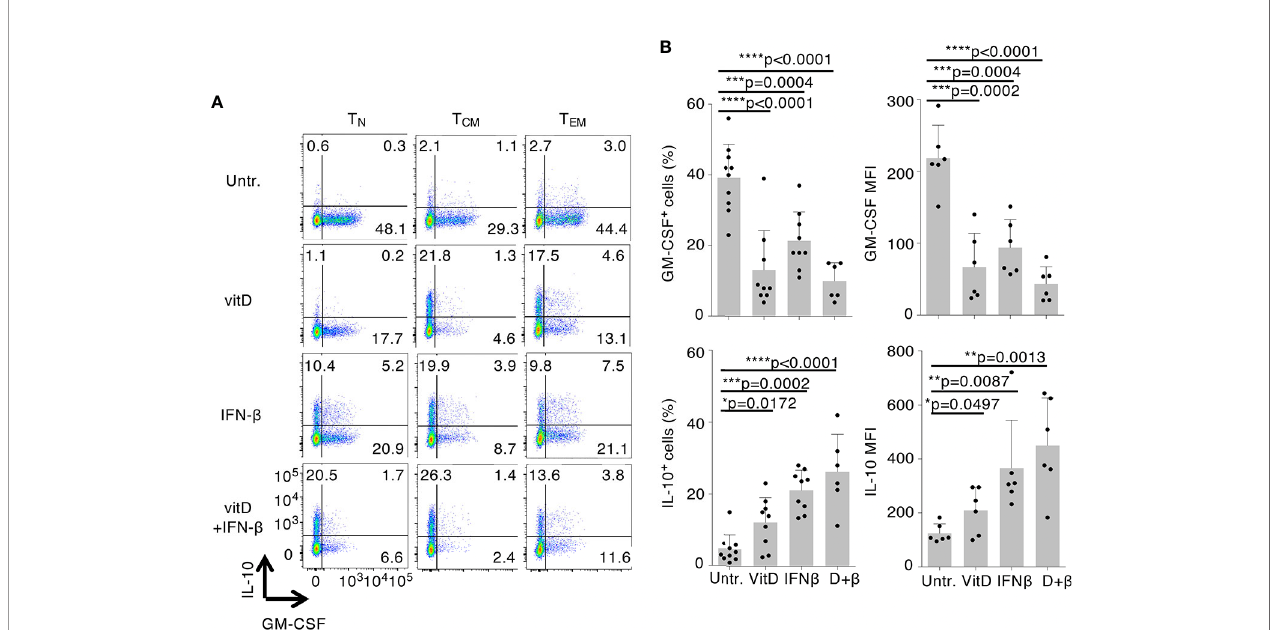
FIGURE 1 | Vitamin D and IFN- b treatment modulate the in fl ammatory phenotype of CD4 + T lymphocytes. (A) Human CD4 + T N , T CM , and T EM cells were activated with plate-bound anti-CD3 and anti-CD28 antibodies in the presence or absence of vitamin D and/or IFN- b . Intracellular staining for GM-CSF and IL-10 expression was performed after 5 days of culture using conjugated antibodies (IL-10-bv421, GM-CSF-PerCp-Cy5.5). (B) Compiled results of T CM cells from different donors treated exactly as in a). Both the percentage of positive cells (left) and the mean fl uorescence intensity (MFI, right) are shown. Each dot represents one donor (at least n=6). Mean ± SD; unpaired t-test, two-tailed, relative to untreated cells *p < 0.05; **p < 0.01; ***p < 0.001; ****p <